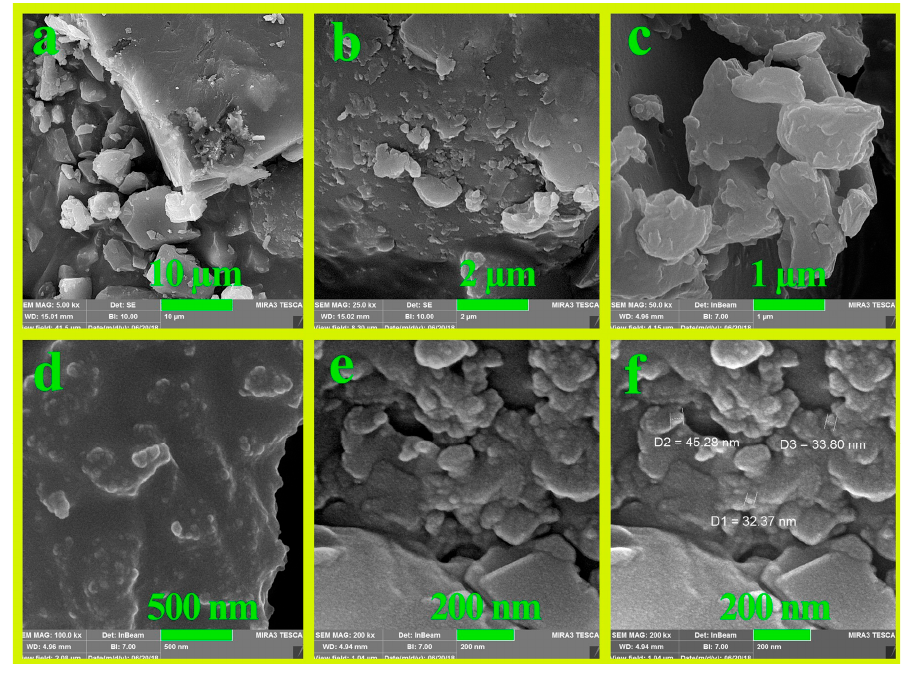
Figure 9. FE-SEM micrographs of NC 2 at different scales.